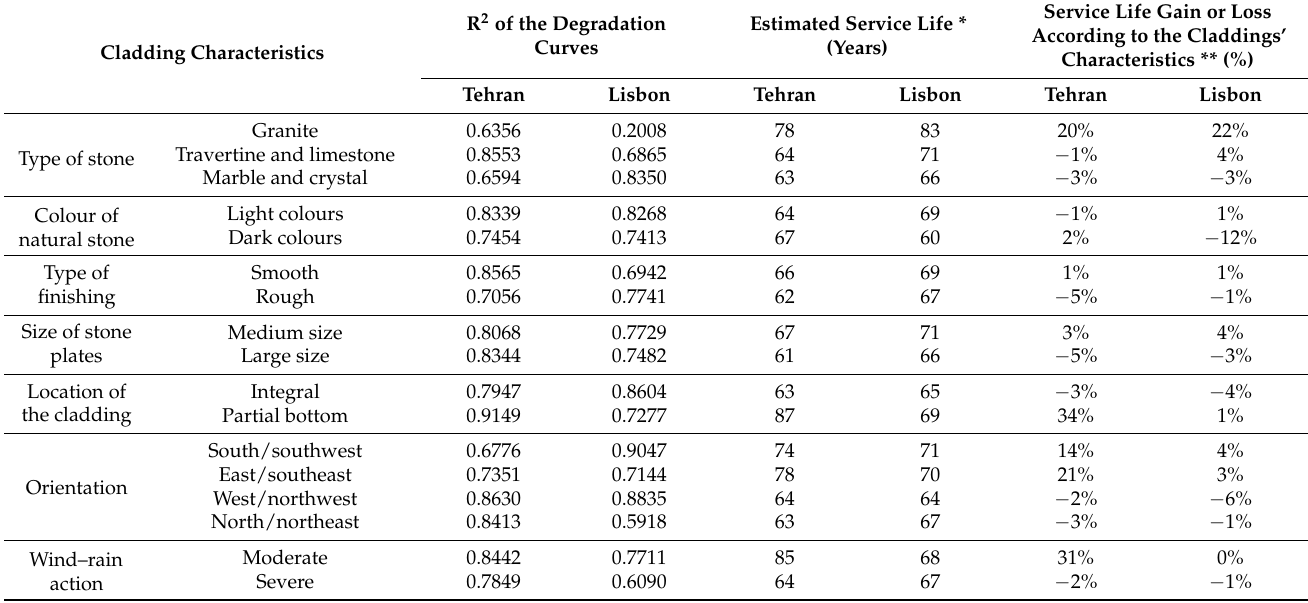
Wind–rain action * The estimated service life is determined using the equations of the degradation curve shown in Figures 7–14. ** These values are obtained through the ratio between the estimated service life for each characteristic and the average estimated service life, which is 65 and 68 years for Tehran and Lisbon samples,